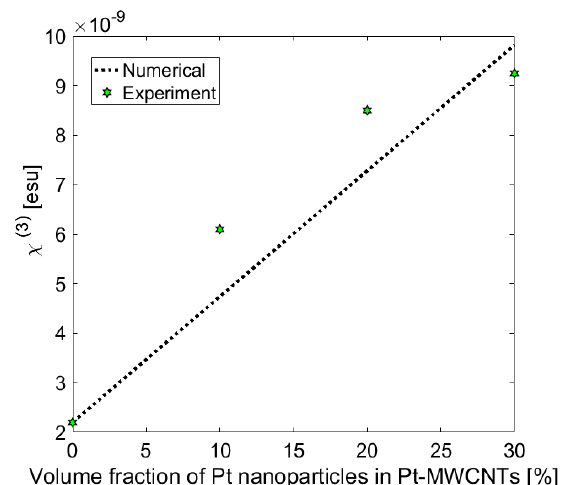
(3) Figure 5. Magnitude of χ ( 3 ) as a function of a change in the volume fraction of nanoparticles of Pt Figure 5. Magnitude of  as a function of a change in the volume fraction of nanoparticles of Pt decorating MWCNT in a sample in film form. decorating MWCNT in a sample in film form.